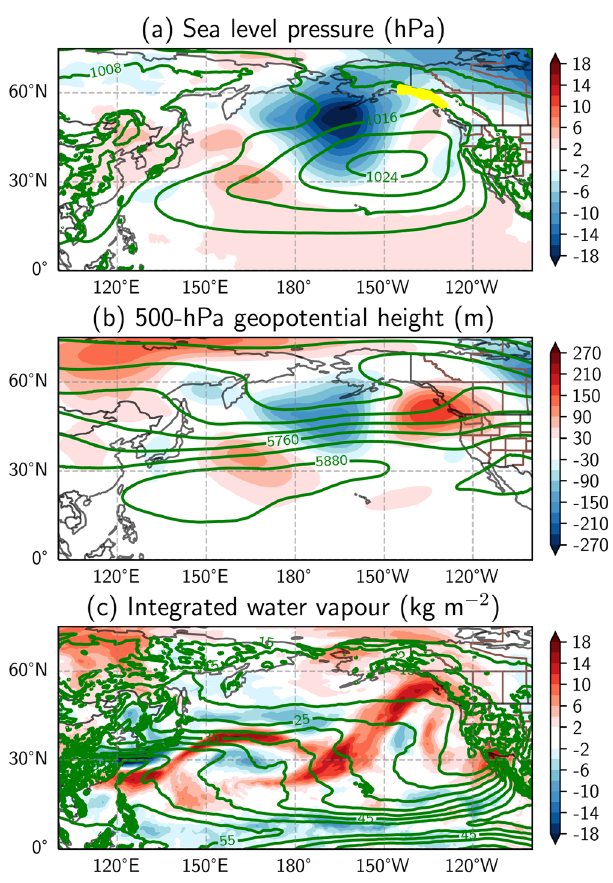
Fig. 3 The anomalies of 5-day (21 – 25 June 2021) mean SLP, 500 hPa geopotential height, and IWV (colour contours) with respect to their 30- year (21 – 25 June, 1991 – 2020) climatology (line contours). The intervals of line contours are 4 hPa in a , 60 m in b , and 5 kg m − 2 in c , respectively. All data are from the ERA5 reanalysis. The yellow band in a highlights the Paci fi c Coast Ranges that separate Alaska from western